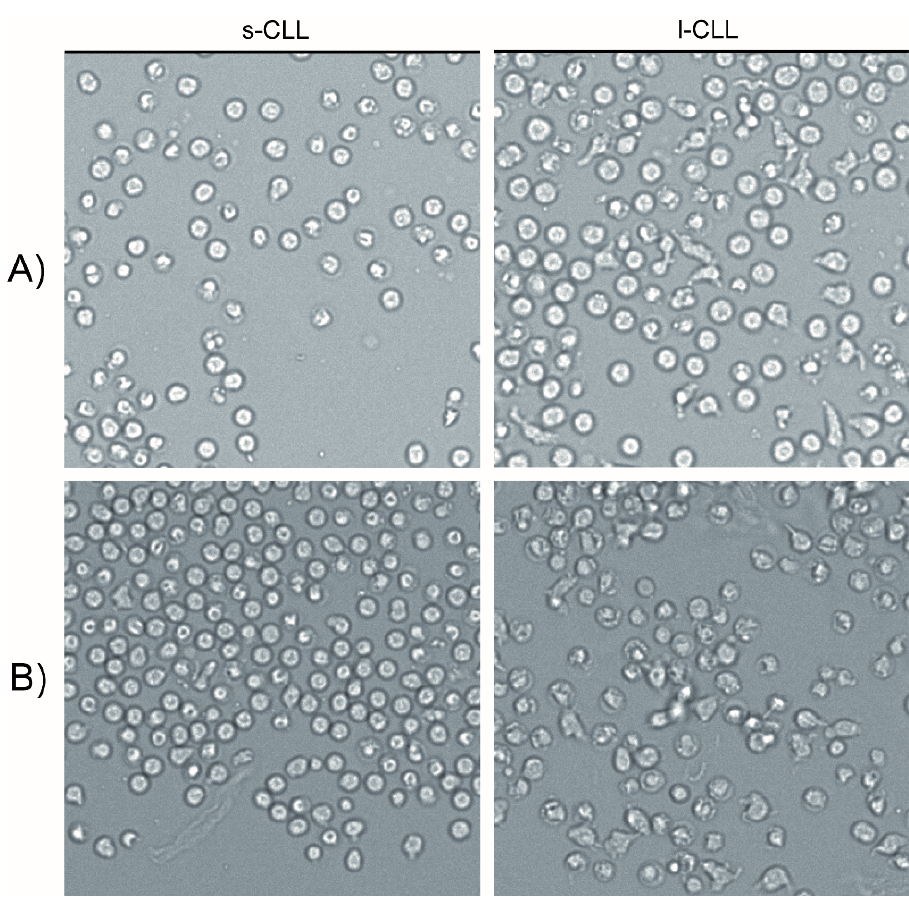
Figure 7. Time-lapse video-microscopy of the sorted s-CLL and l-CLL cells stimulated with ( A ) CpG for 24 h and ( B ) CXCL12 (representative examples). For the time-dependent changes in cell shape and motility see Supplementary Videos S1–S4.